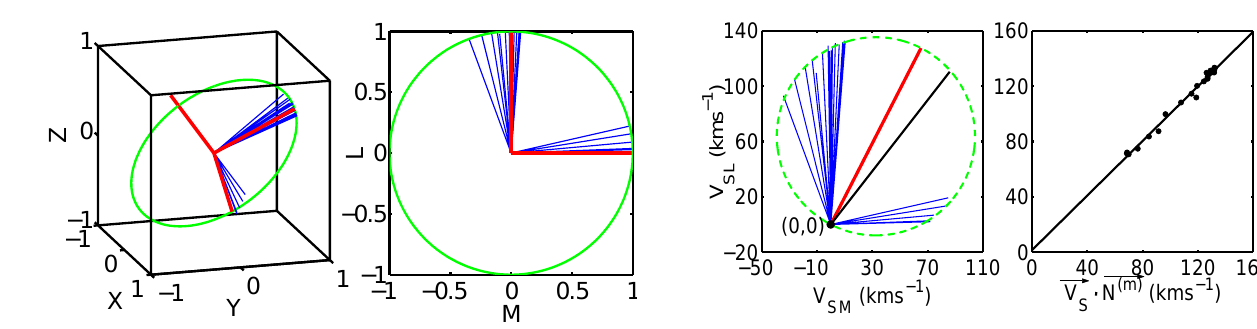
Fig. 4. The MTA analysis on the event during 00:46:40 UT to 00:47:30 UT. The blue lines show the normal directions obtained by the Triangulation method as the first step of MTA, and the red lines are the three eigenvectors of the corresponding matrix. The green circle represents the cross-section plane of the flux rope, basically containing all of the blue lines, while the red line perpendicular to the green circle suggests the flux rope orientation. The left box is in GSM, while the right one is in the LMN coordinate system defined by three eigenvectors.